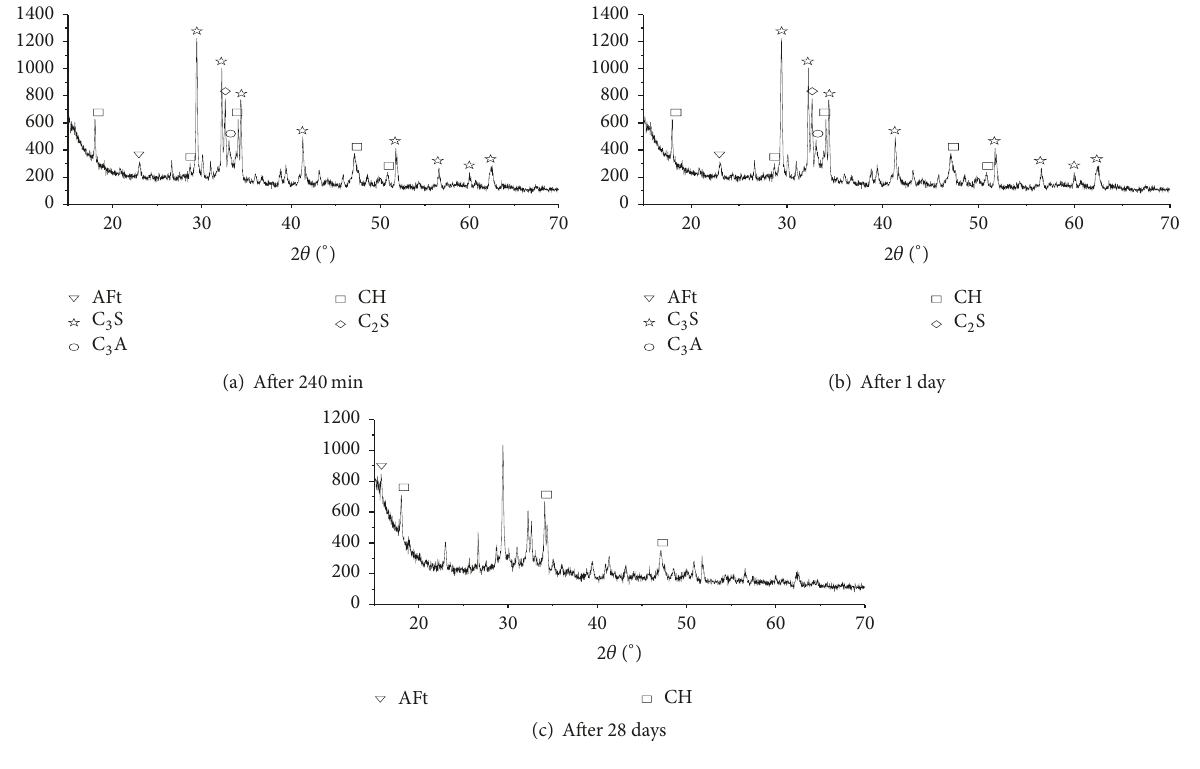
Figure 5: The XRD diffractograms of the hydrated cement samples without the accelerator.